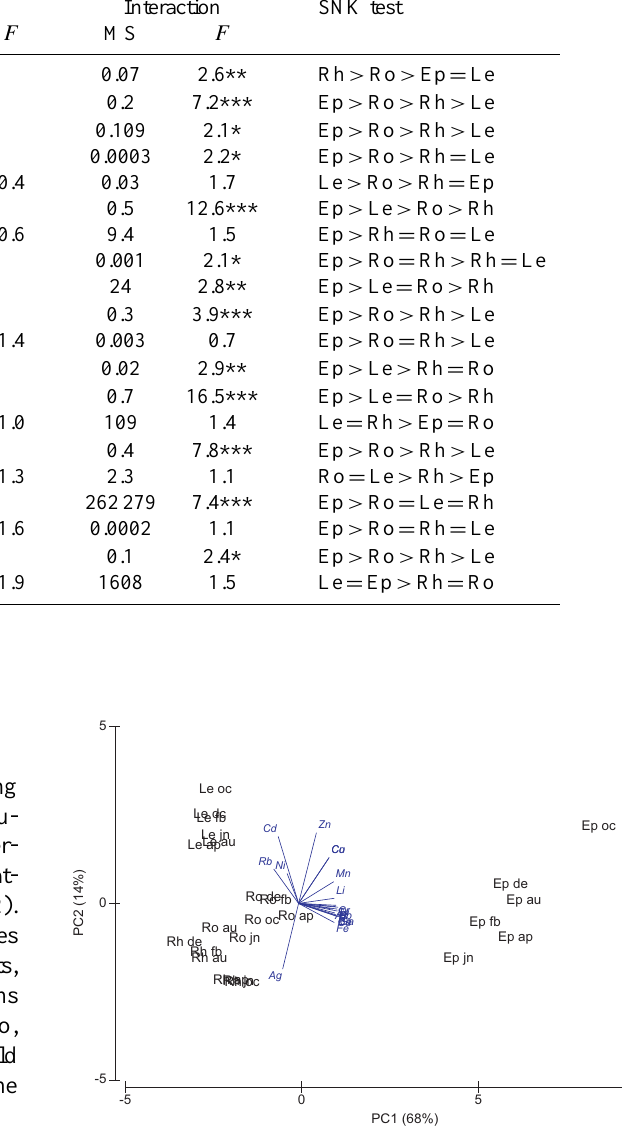
plant compartments, showing that trace element concentra- tion among plant compartments was highly dependent on the trace element. The epiphyte samples showed significantly ( p < 0 . 05) highest concentrations in most elements (As, Ba, Bi, Co,